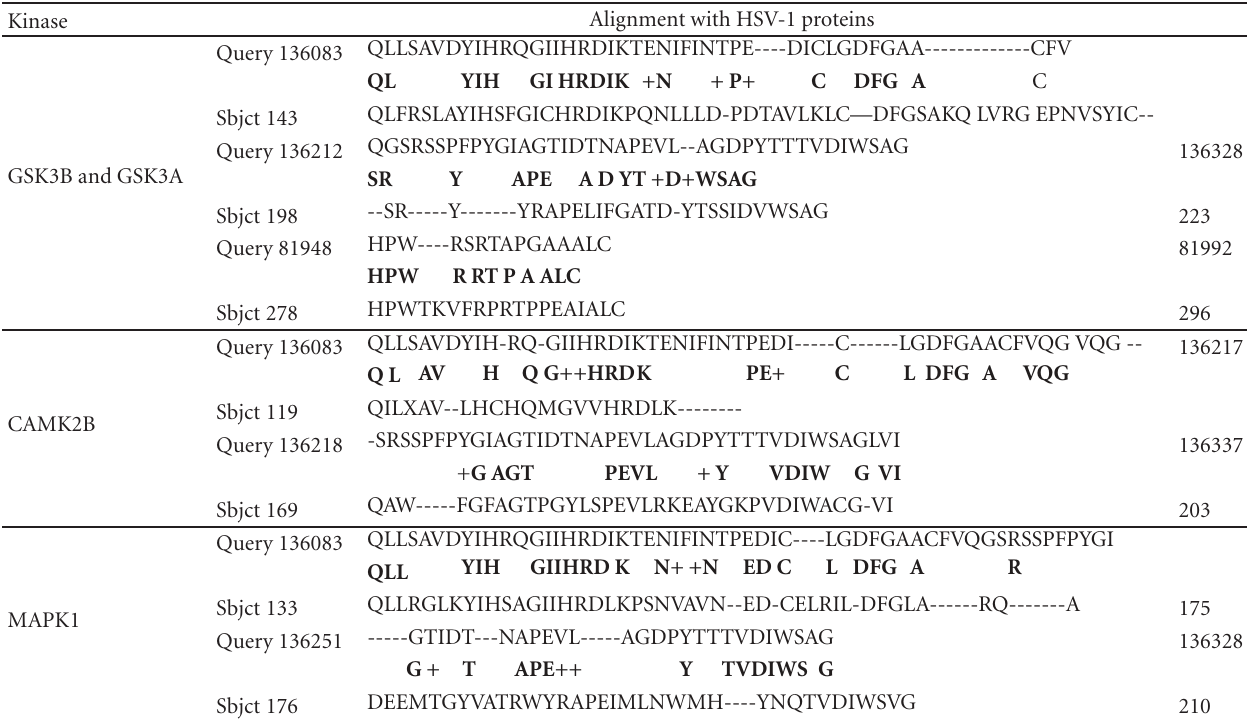
Table 4: Alignment of the HSV-1 translated genome (Query) with 3 protein kinases known to phosphorylate tau (Sbjct). Glycogen synthase kinase GSK3A aligns with the same amino acids as GSK3B. CAMK2B: calcium/calmodulin-dependent protein kinase II beta. MAPK1: mitogen-activated protein kinase 1